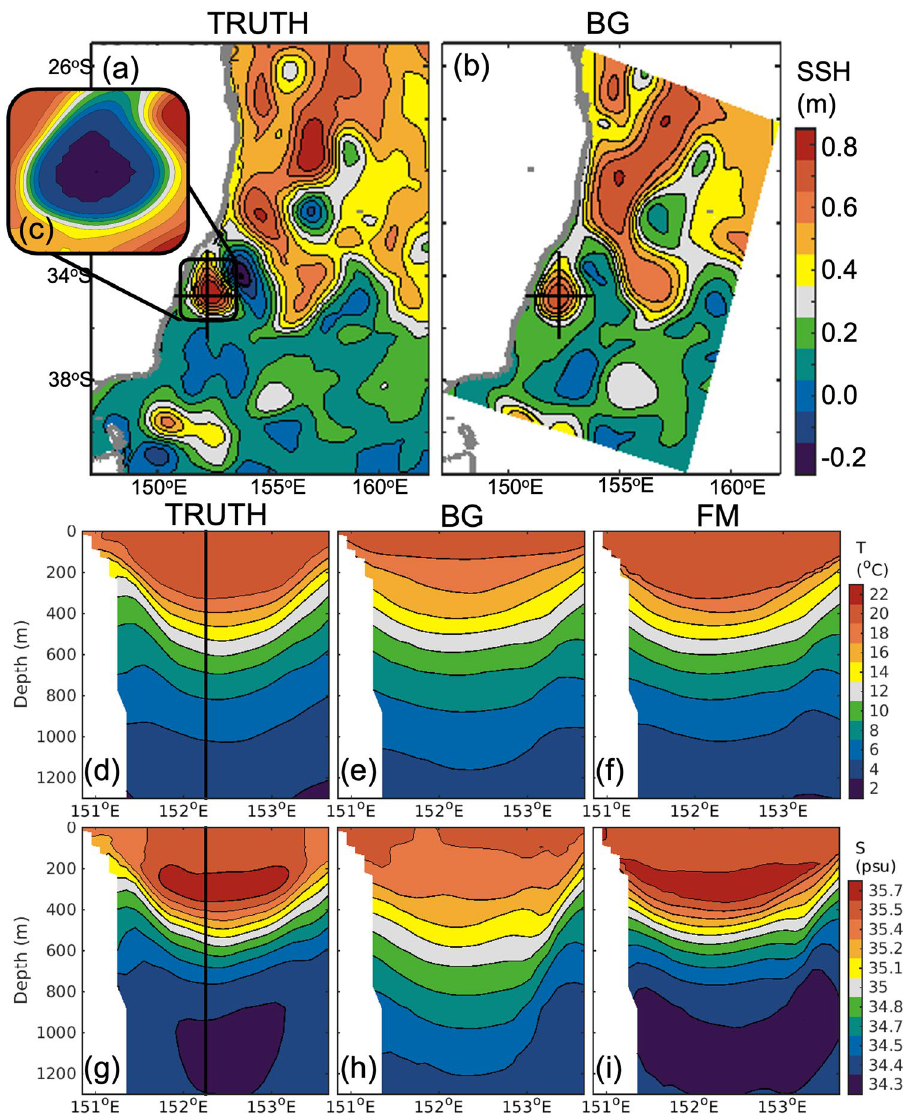
( c ) Two-dimensional mask used to define the feature. Longitude-depth sections of ( d–f ) temperature and ( g–i ) salinity, showing fields from the ( d,g ) truth (the vertical black line denotes the location of the “observed” profile used for feature-mapping), ( e,h ) background (BG), and ( f,i ) feature-mapped (FM)